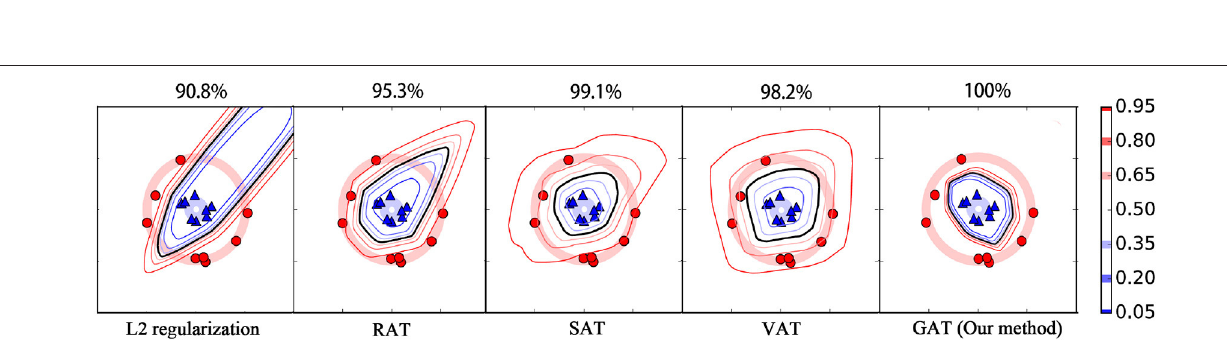
FIGURE 4 | The contour of output confidences for label 1 on M -dataset with various regularization methods. The red circles and blue triangles represent the data points with labels 1 and 0, respectively. The decision boundaries with different confidences are plotted with different colored contours. Note that the black line represents the contour of probability value 0.5, which is usually served as the decision boundary for the binary classification task. The accuracy rate of each method for the test examples is displayed above the panel.